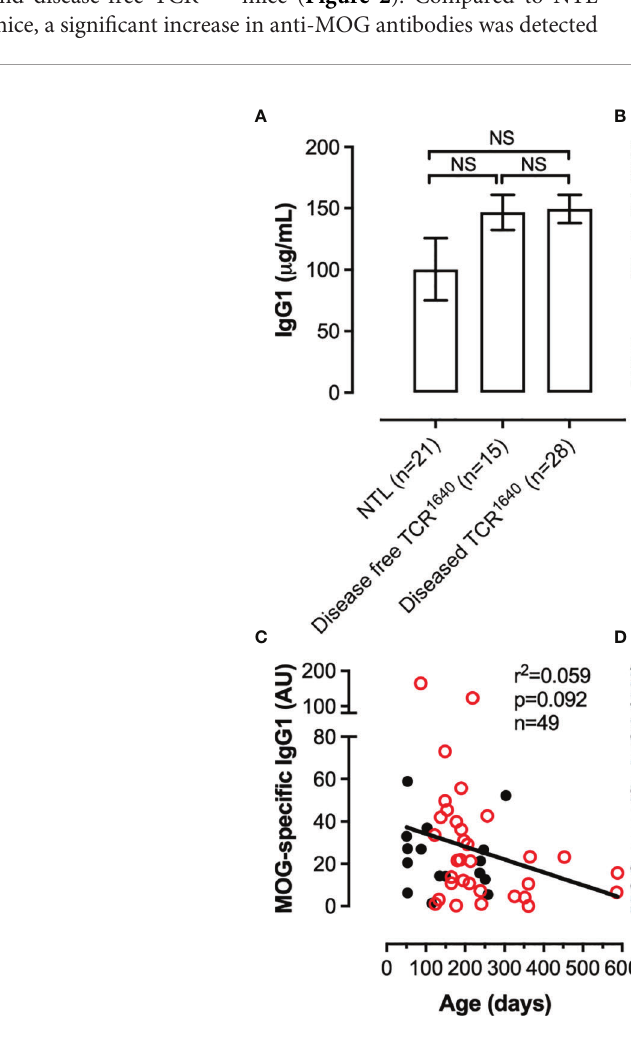
FIGURE 2 | A MOG-speci fi c humoral response develops in TCR1640 mice independent of clinical disease. (A) Total IgG1 and (B) MOG-speci fi c IgG1 antibodies were detected in the sera of NTL, Disease-free TCR 1640 and diseased TCR 1640 mice. Data represents the mean ± SEM of n serum samples. Correlation with (C) age or (D) clinical intensity of MOG-antibody titres for individual disease-free TCR 1640 (Black circles, n = 23) and diseased TCR 1640 mice (Red circles, n = 33). Student t- test (A, B) ; Fisher exact for linear regressions (C, D) . NS, Not Signi fi cant; ***p < 0.001; ****p <